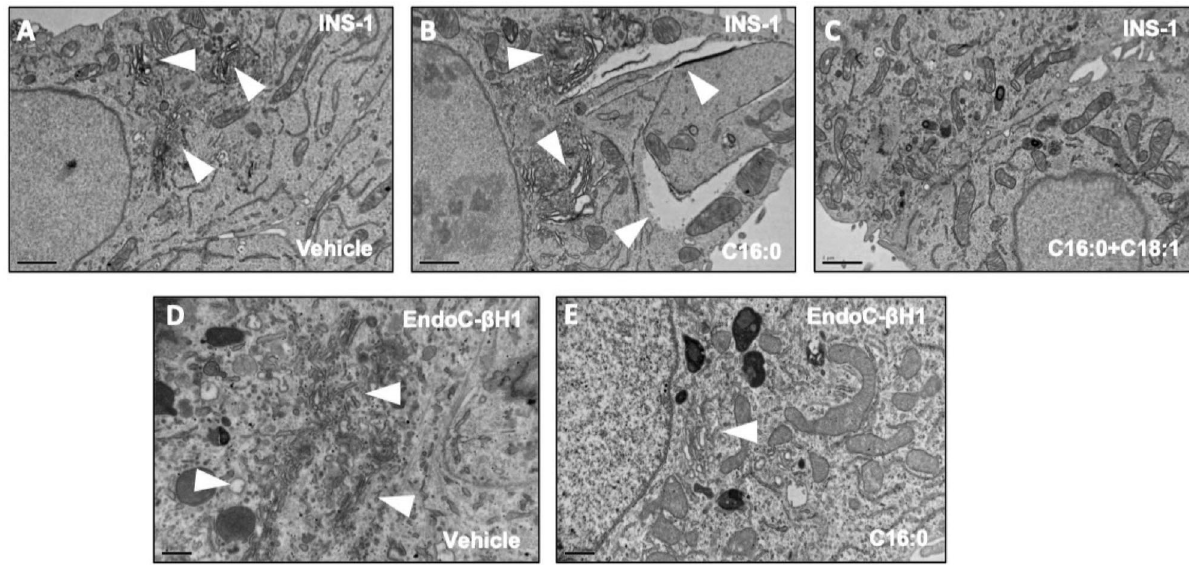
Fig. 3 Effect of palmitate (C16:0) on the morphology of rodent and human β -cells. Representative transmission electron microscopy images of INS-1 823/13 cells ( A – C ) and EndoC- β H1 ( D , E ) cell morphology following a 6 h treatment with BSA vehicle control ( A , D ‘ vehicle ’ ) or 250 μ M C16:0 ( B , E ) without or with 250 μ M C18:1 ( C ) ( N = 2). Arrows point towards the Golgi apparatus and the distension of intracellular